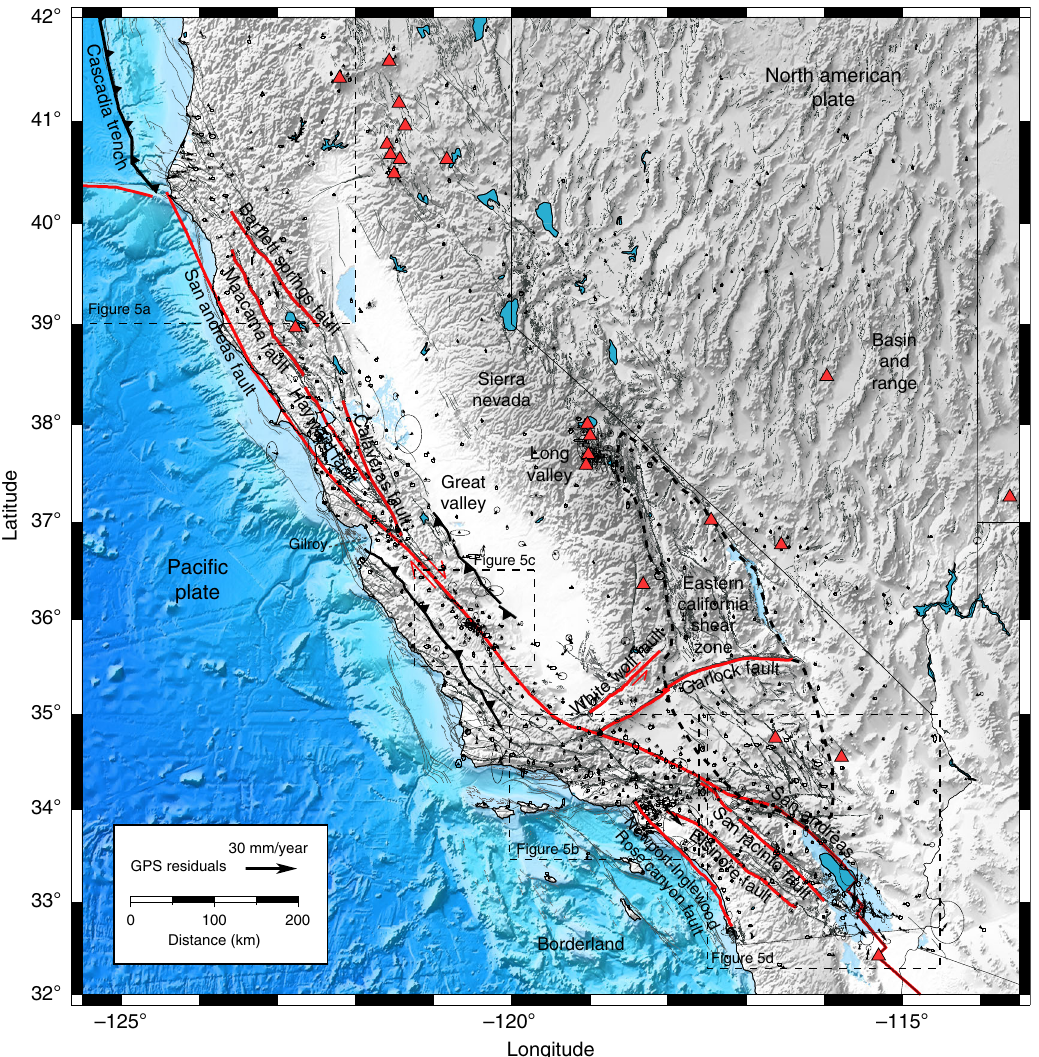
Fig. 4 GPS residuals velocity. Residuals are plotted at the same scale as in Fig. 2. The largest spatially coherent residuals occur off the Cascadia trench, around Park fi eld, in the Transverse Range, and around the recent 1999 Hector Mine and 2010 El Mayor-Cucapah earthquakes, shown in more detail in Fig. 5. The red triangles correspond to quaternary